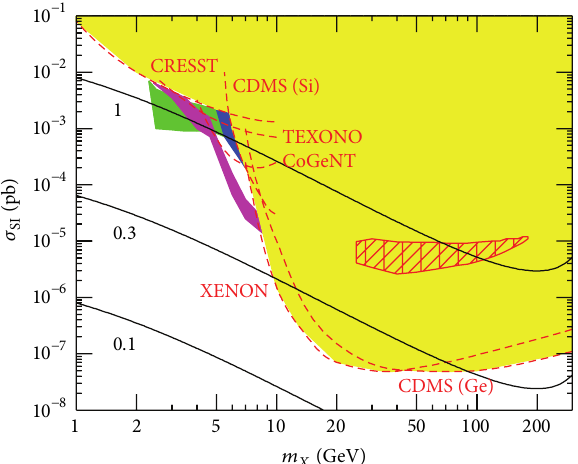
Figure4:Directdetectioncross-sectionlimitsforspin-independent 𝑋 -nucleon scattering as a function of DM mass 𝑚 𝑋 . The solid curves are the predictions for WIMPless DM with mediator mass 𝑚 𝑄 󸀠 = 400 GeV and the Yukawa couplings 𝜆 𝑏 indicated. The light yellow shaded region is excluded by the experimental results indicated. The dark blue, medium green, medium-dark magenta, and cross- hatched regions are the DAMA-favored regions under different assumptions, see [29] for details. Figure from